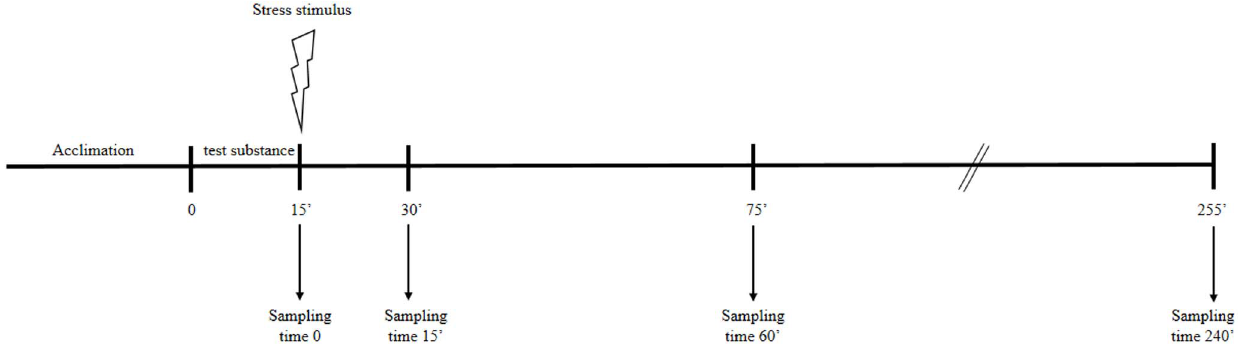
Figure 1. Schematic view of the experimental design of the study. The test substance refers to the control (no substance), diazepam (0.88, 16, or 160 m g/L) or fluoxetine (1, 25 or 50 m g/L).